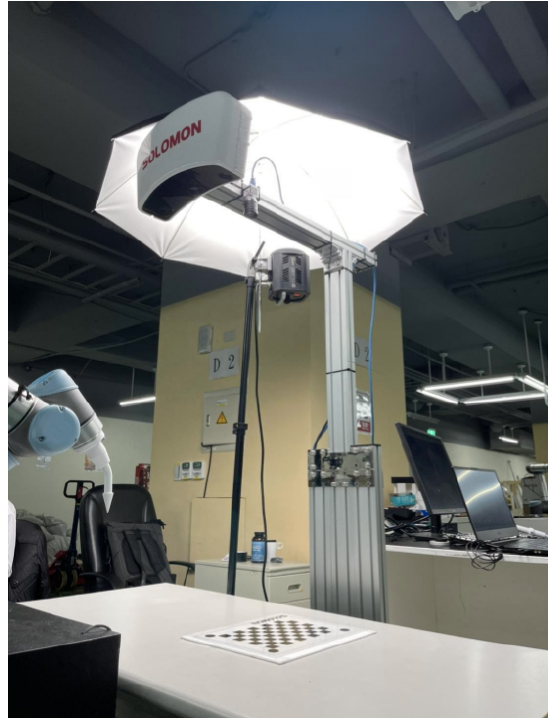
Figure 9. Overall